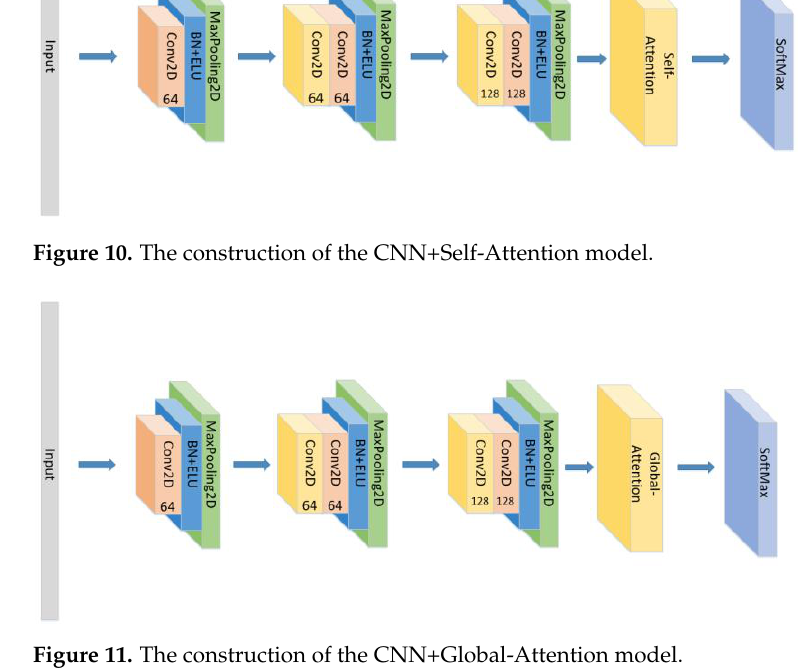
Figure 11. The construction of the CNN+Global-Attention model.